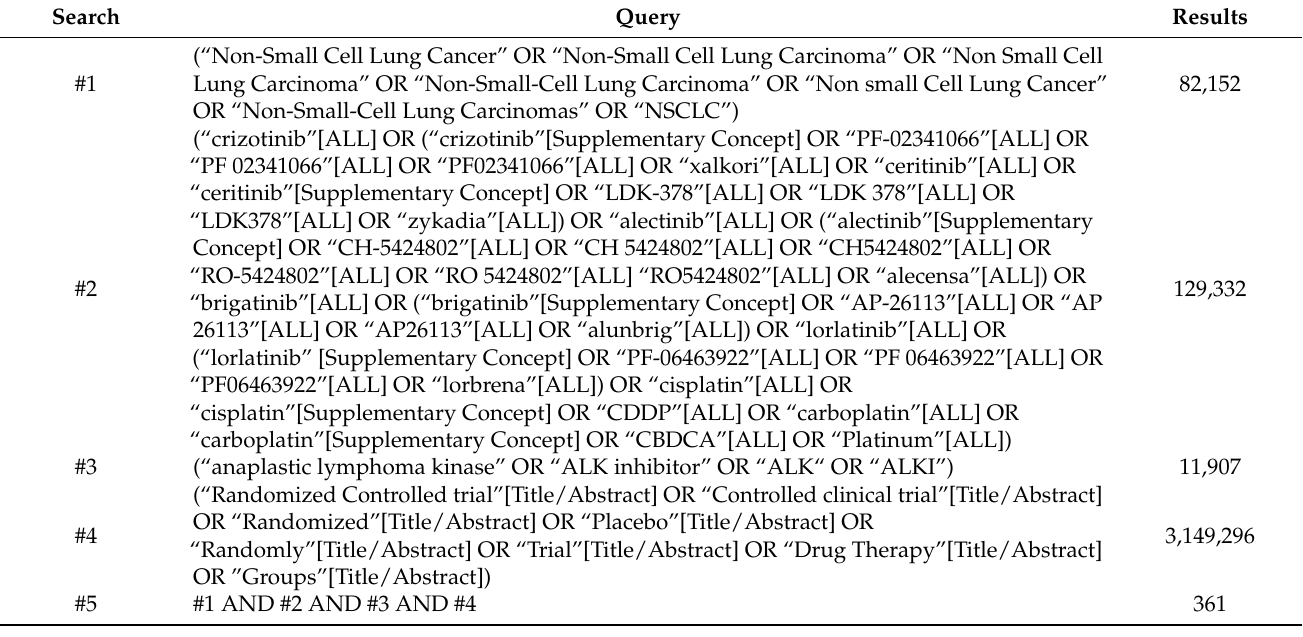
Table A1. Search Strategies in PubMed (Searched on 6 May